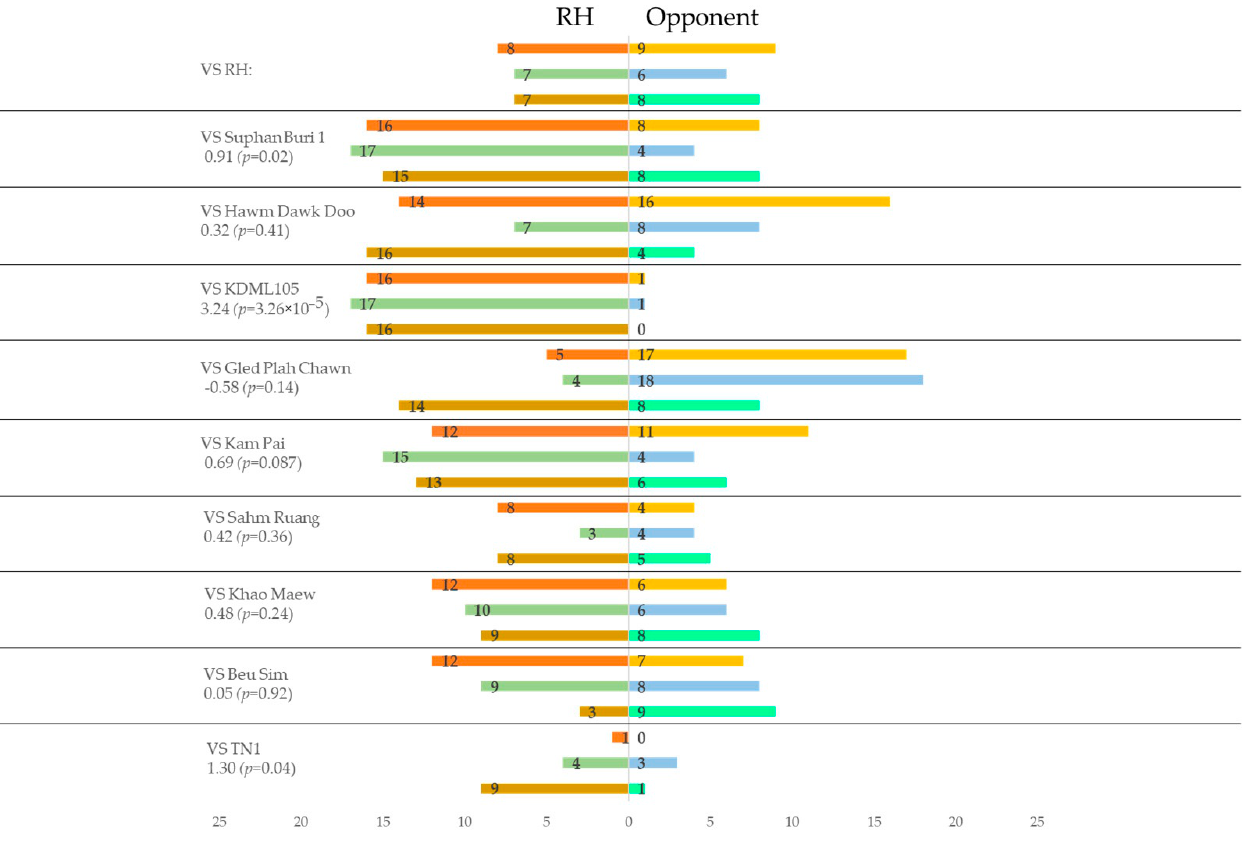
Figure 3. Relative olfactory preferences of BPH for volatiles from rice plants of RH variety to the others determined by two–choice tests using potted plants with BPH infestation. 3.4. VOCs 10 Rice Varieties before and during BPH Infestation A total of 45 VOCs were identified from rice plants without BPH infestation. The greatest numbers of compounds were identified in the RH variety (17 compounds), fol- lowed by Gled Plah Chawn (12) and TN1 (8) (Table 6). On the other hand, the number